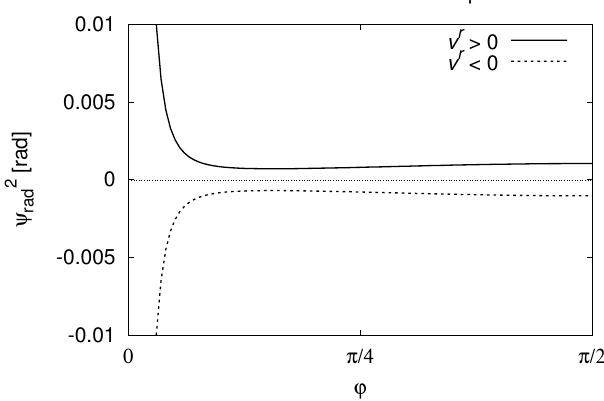
Figure 4. φ dependence of Equation (45).